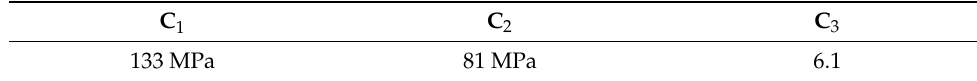
Table 2. Fitting parameters of the Voce hardening model.